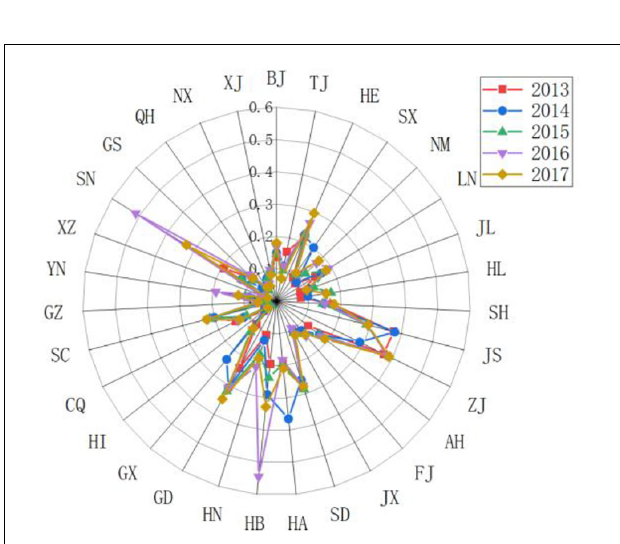
FIGURE 8 | Comparing the scores of the sports development resilience response subsystem in various provinces in